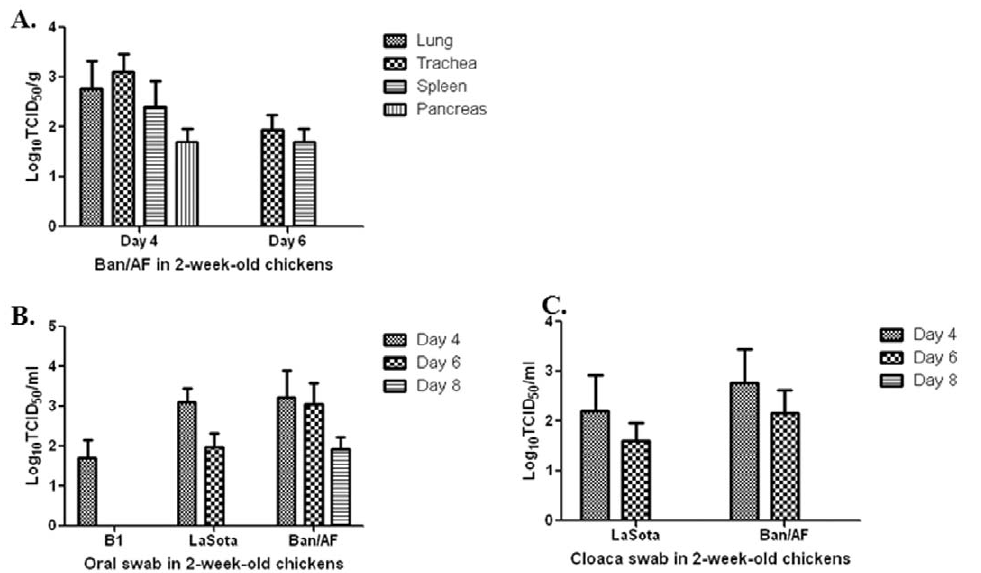
Figure 6. Replication and shedding of vaccine viruses Ban/AF, B1 and LaSota in 2-week-old chickens. Chickens in groups of 3 were infected with virus by a single nasal drop each, as described in Materials and Methods. At 4, 6, and 8 dpi, three birds per virus per day were sacrificed, and tissue from the indicated organs, as well as oral and cloaca swabs, were collected. These were assayed for the presence of virus by inoculation into 9-day embryonated chicken eggs, as summarized in Table 6. Samples that were positive in Table 3 were analyzed to determine virus titers by TCID50 assay. Samples: lung, trachea, spleen, and pancreas (A), oral swabs (B), cloaca swabs (C). doi:10.1371/journal.pone.0052751.g006 PLOS ONE |